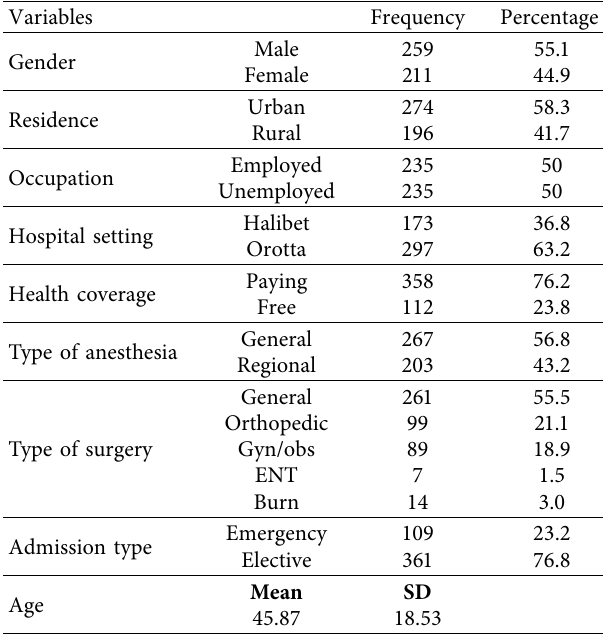
Table 1: Demographic and clinical characteristics of the